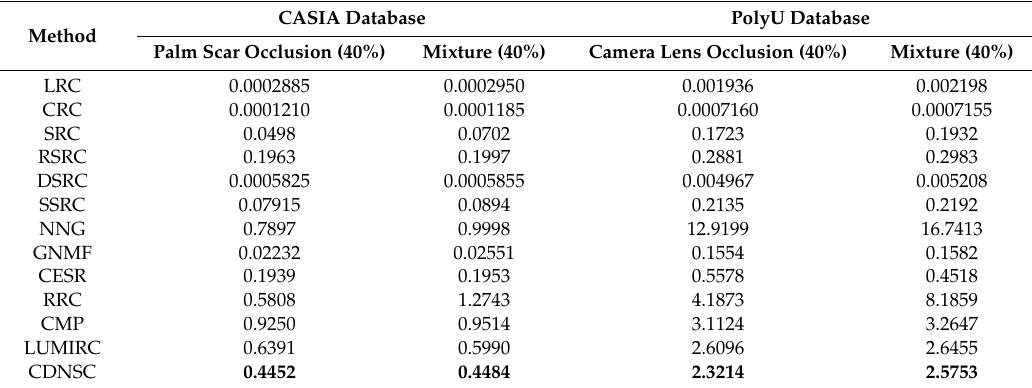
Table 3. Average running time (Seconds) of all the methods regarding the two